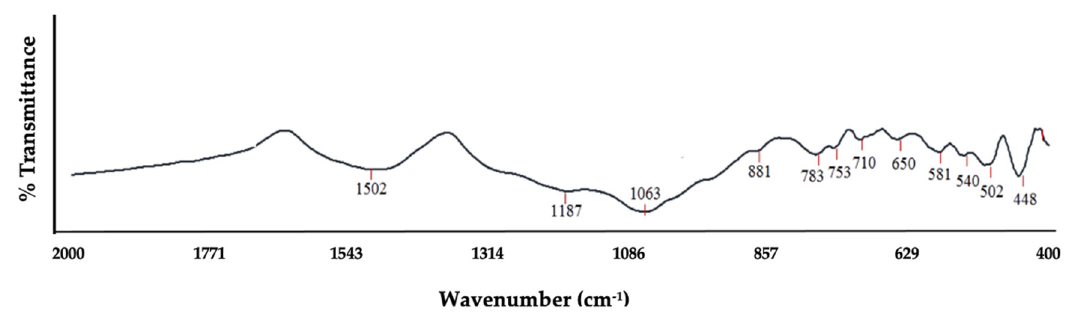
Figure 3. XRD patterns of raw corn stover ash (as received).